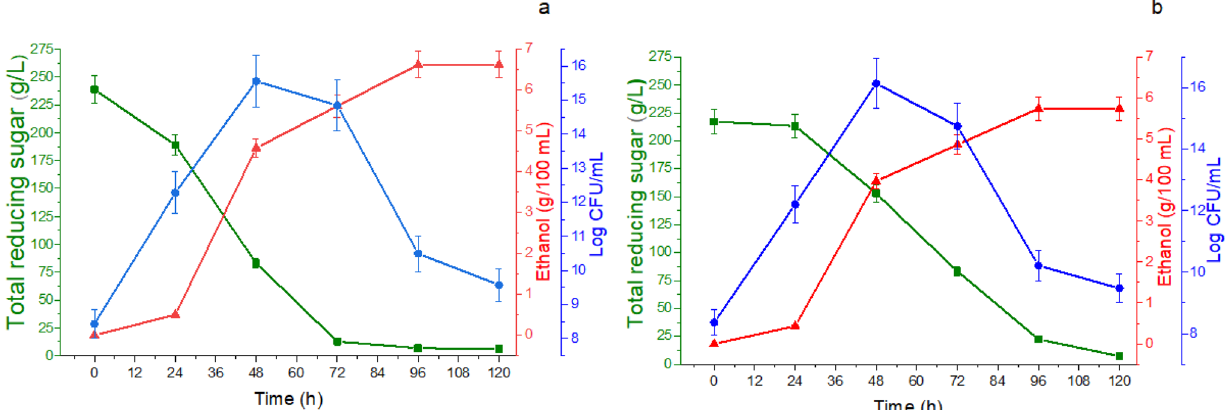
Figure 2. Alcoholic fermentation of musts from ( a ) pineapple pulp and ( b ) pineapple peel showing the kinetic profile of reducing sugars (green filled square box), ethanol production (red filled uptriangle), and cell growth (blue filled circle) in the winemaking